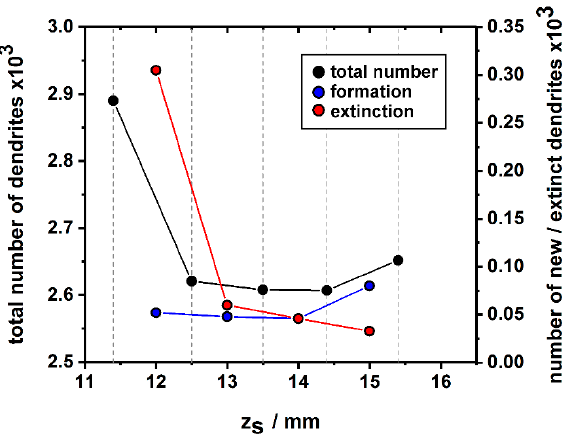
Figure 13. Evolution of dendrite numbers. The total number of dendrites is presented by black symbols (data values on left vertical axis). The plot shows the numbers of newly-formed (blue symbols, data values on right vertical axis) and extinct dendrites (red symbols; data values on right vertical axis) in the first 4 mm of the solidifying rod (evaluated from full cross section of the rod). Detailed cummulative histograms, which are based on the spacings of all dendrites which were detected in each 113 mm 2 sample cross section, are presented in Figure 14.